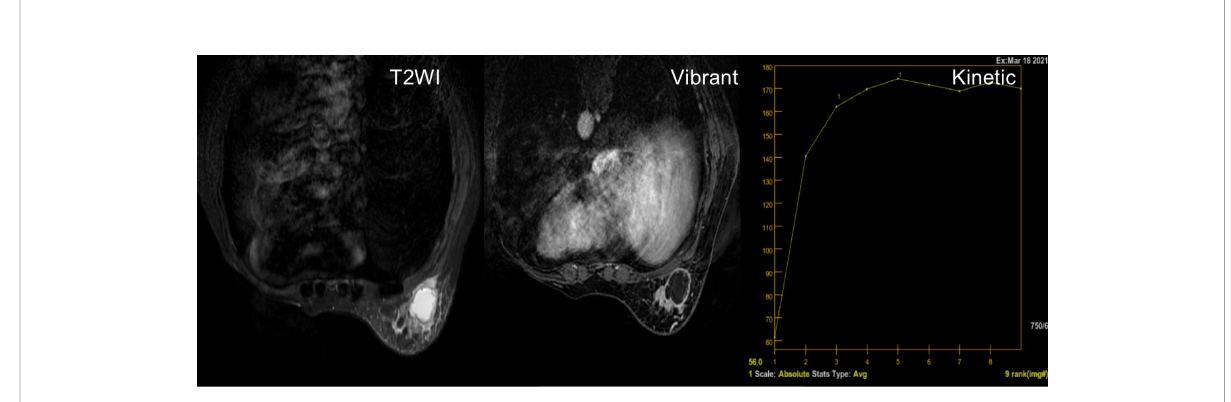
FIGURE 2 A 50-year-old woman with a solitary hyperintensity in T2 lesion, with rim enhancement in Vibrant and a type II kinetic curve (plateau).